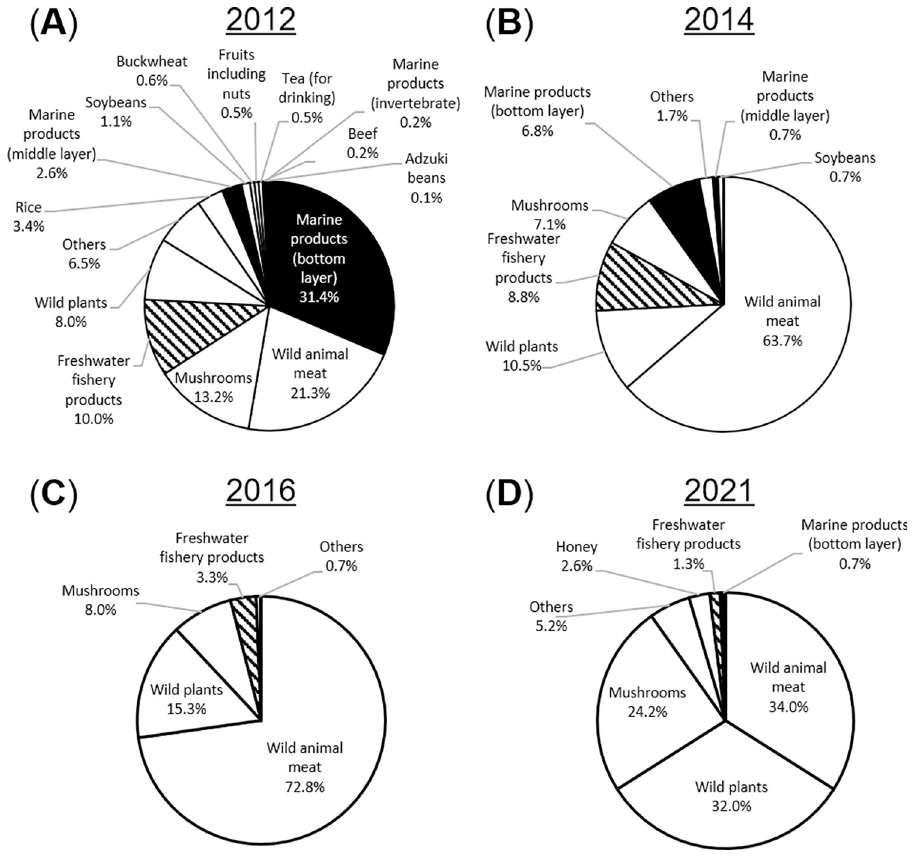
Fig 2. Annual trends of the “general foodstuffs” reported exceeding the JML ( > 100 Bq/kg). Food categories examined and reported as exceeding 100 Bq/kg. Pie graphs show the proportions of food categories reported in each FY: ( A ) 2012; ( B ) 2014; ( C ) 2016; and ( D ) 2021. Freshwater fishery foodstuffs and other fishery foodstuffs including marine products are shaded with lines and filled in black, respectively. All data reported in the database were included in the